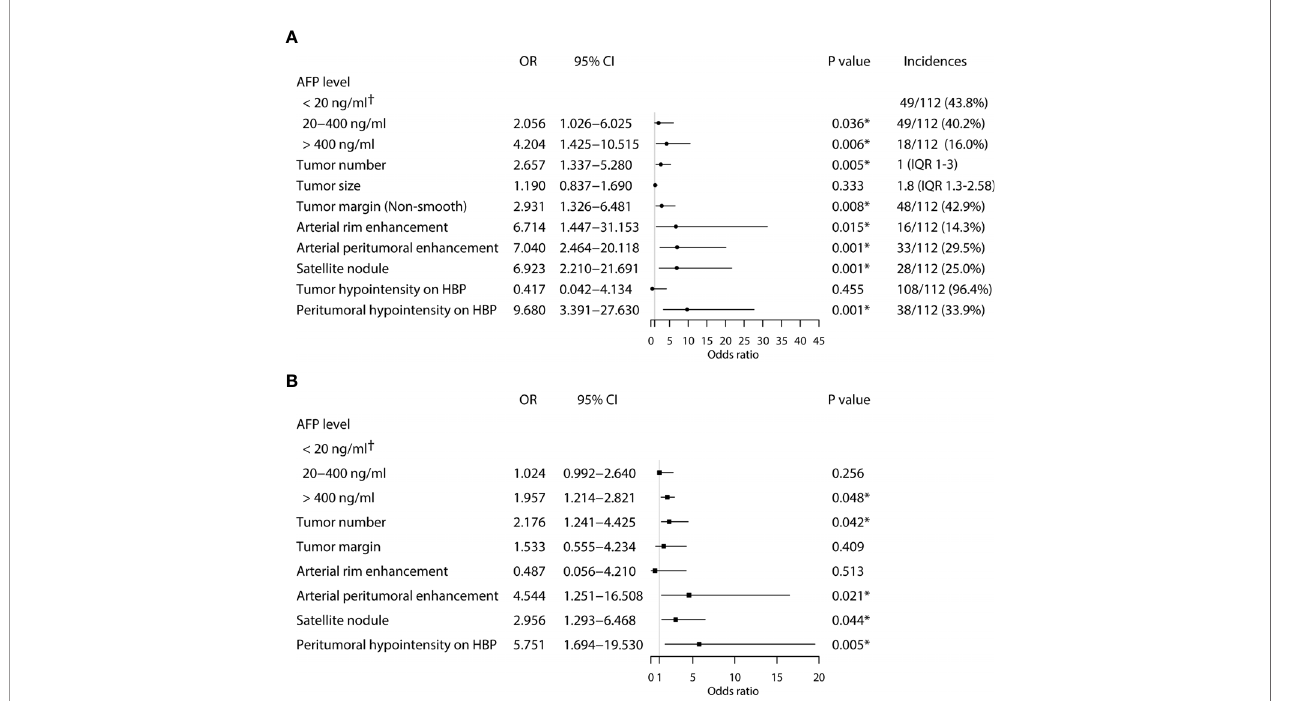
FIGURE 2 | Univariate (A) and multivariate (B) analyses of independent risk factors associated with early HCC recurrence in the training cohort. (*Statistically signi fi cant results from logistic regression analysis; † Used as the reference